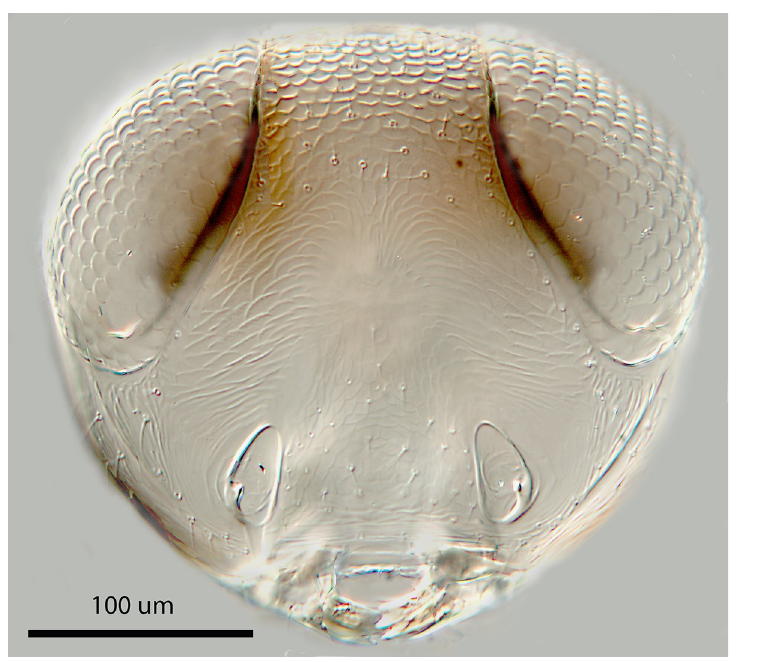
Fig 4. M . macadamiae female holotype, head, frontal